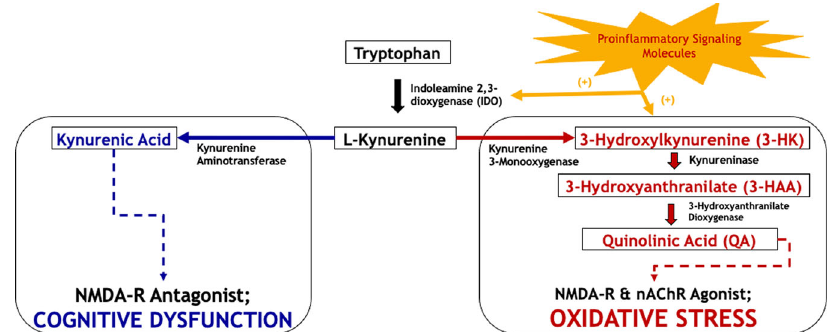
Fig. 1 Kynurenine metabolic pathway. 3-HK 3-Hydroxykynurenine, 3-HAA 3-Hydroxyanthranilic acid, QA Quinolinic acid, NMDA-R N-methyl-D-aspartate receptor, nAChR Nicotinic